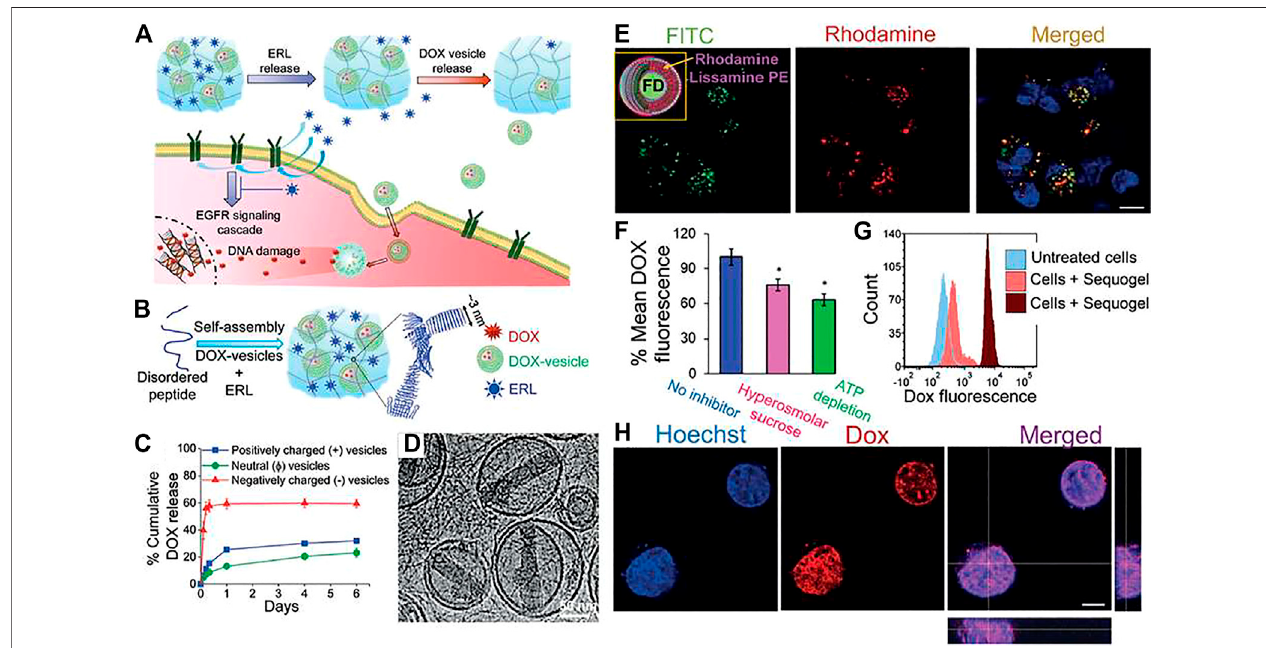
FIGURE 5 | The time-staggered delivery of ERL and DOX-containing vesicles from Sequogel. (A) Schematic presentation of the time staggered delivery process. (B) Schematic diagram showing preparation of Sequogel consisting of MAX8 peptide in presence of ERL and DOX-loaded vesicles. (C) DOX releasepro fi le from 1 wt% peptide gel containing negatively charged (POPS/PC/cholesterol), positively charged (DOTAP/PC/cholesterol), and neutral (PC/cholesterol) vesicles. (D) Cryo-TEM image of Sequogel containing DOX-loaded vesicles encapsulated within the peptide hydrogel. (E) a) LN229 cellular uptake and localization of labeled vesicles releasedfrom Sequogel. (F) Mechanism ofcellular uptake of DOX-loaded vesicles released from Sequogel. Cells were incubated withSequogel for 1 h with and without endocytic inhibitors. Mean fl uorescence intensities of DOX under each inhibition condition were compared to those in absence of inhibitor to determine statistical signi fi cance, indicated by * for p < 0.05. (G) Histograms from fl ow cytometric detection of DOX internalization 4 and 16 h post-incubation with Sequogel. (H) Live-cell imaging of LN229 cells after addition of Sequogel containing DOX vesicles and ERL at 16 h post-incubation. Reproduced with permission (Majumder et al., 2018). Copyright 2018